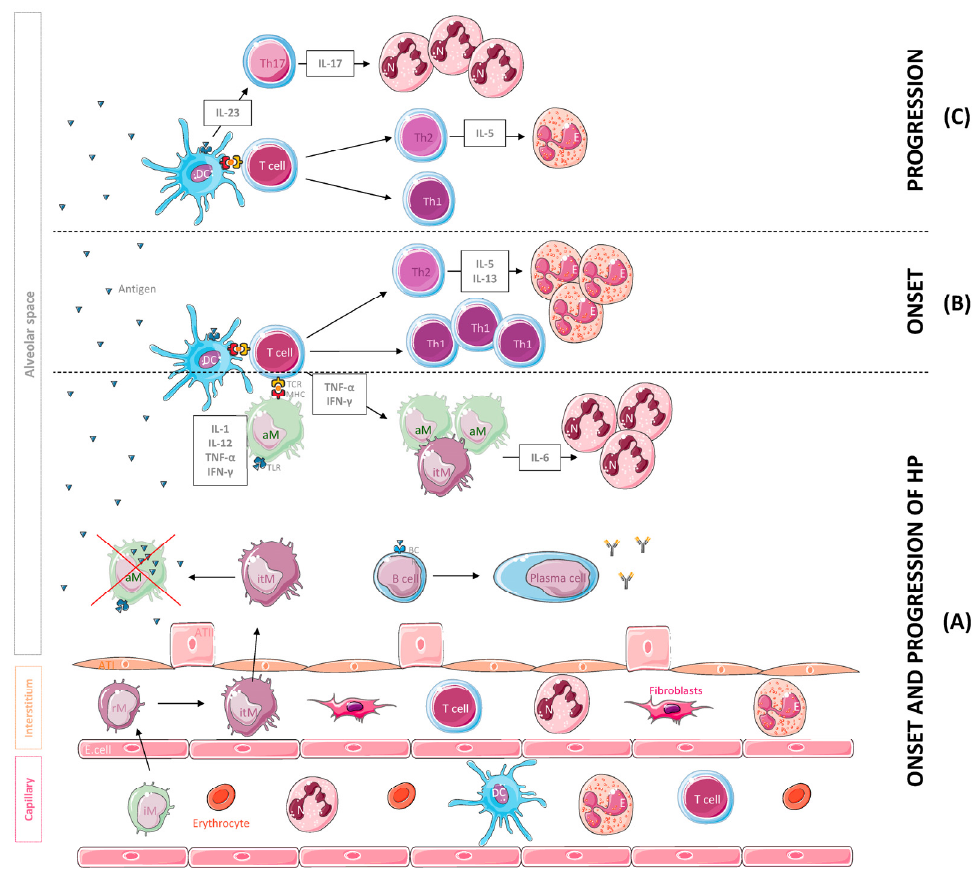
Figure 1. Leukocyte population and cytokines mainly involved in the onset and the progression of hypersensitivity pneumonitis (HP). ( A ) Following inhalation, the antigen is phagocytosed and degraded by dendritic cells (DCs) and macrophages and coupled to MHC molecules. The antigen is then recognized by T cells that secrete cytokines such as IFN- γ and TNF- α , inducing the accumulation, activation and aggregation of IL-6-producing macrophages, a potent chemoattractant for neutrophil (N) recruitment and activation. A B cell response against the antigens also occurs, leading to the production of specific antibodies. For their part, alveolar macrophages (aMs) may undergo subsequent apoptosis after the phagocytosis of high levels of the antigen and inflammatory monocytes (iMs), which are recruited to the lung tissue from the vasculature and differentiate into resident monocytes (rMs) and interstitial macrophages (itMs) afterwards. Subsequently, itMs proliferate and migrate into the alveolar space to restore this depleted population. ( B ) In the onset of the disease, T cells differentiate into Th1 and Th2 effectors, and Th2 cells release cytokines such as IL-5 and IL-13 that promote eosinophil recruitment and activation. ( C ) With progression of the disease, Th2 cells decrease IL-5 secretion, resulting in a reduction in eosinophils in the site of inflammation. In addition, DCs start secreting IL-23, a cytokine that promotes Th17 cell differentiation, IL-17 secretion and neutrophil aggregation. Abbreviations: ATI, alveolar type I cell; ATII, alveolar type II cell; E. cell, endothelial cell.